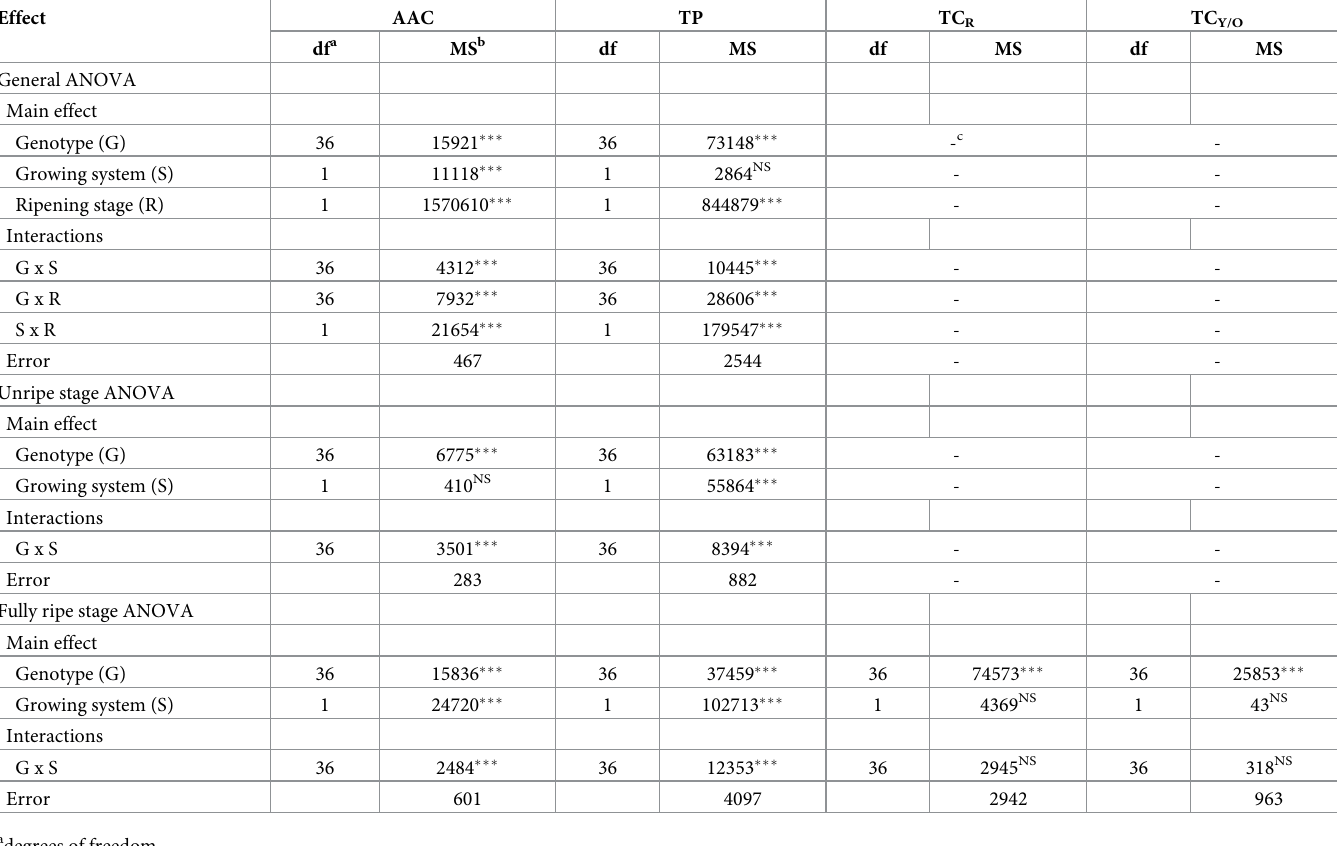
Table 2. General ANOVA for the content of ascorbic acid (AAC) and total phenolics (TP) and specific ANOVA corresponding to each ripening stage for AAC, TP, total red carotenoids (TCR), and total yellow/orange carotenoids